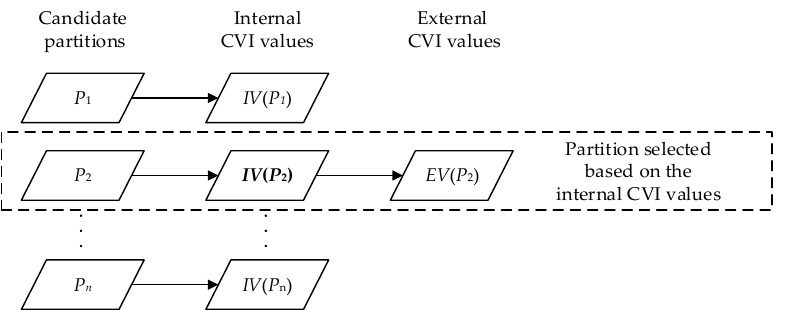
Figure 4. Procedures of the hierarchical and k -modes clustering validation experiments.